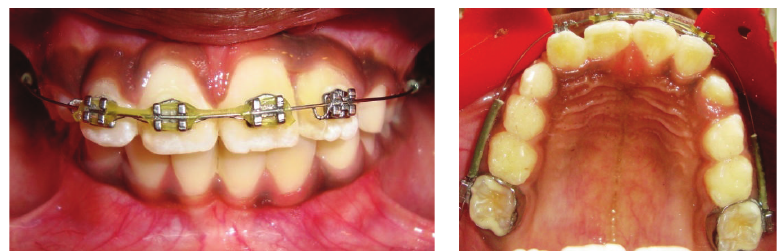
Figure 4: Midtreatment photograph shows correction of fused teeth.